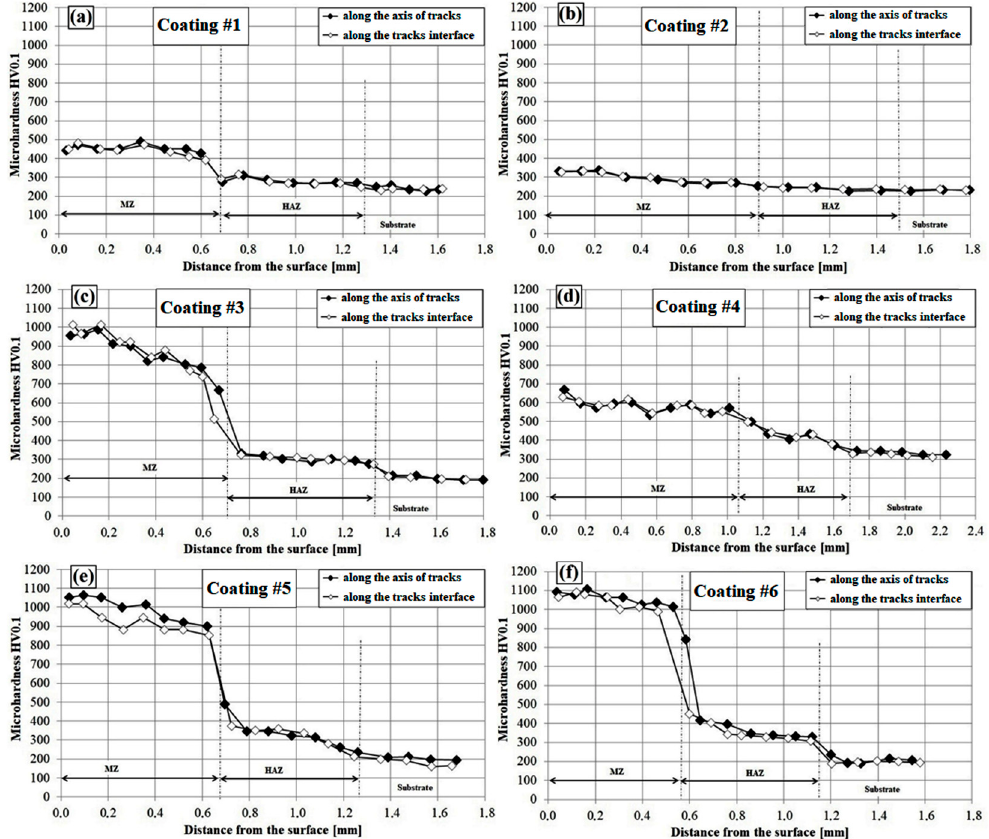
Figure 7. Microhardness profiles of C45 steel with Fe–B and Fe–B–B 4 C–Si composite coatings obtained by laser cladding technology using different laser parameters: ( a ) coating #1; ( b ) coating #2; ( c ) coating #3; ( d ) coating #4; ( e ) coating #5; ( f ) coating #6. (specimen numbers in accordance with Table 2).